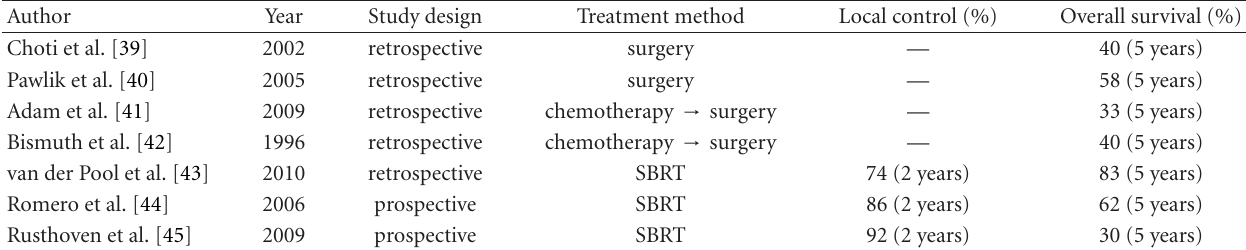
Table 2: Outcomes of oligometastases and oligo-recurrence in the